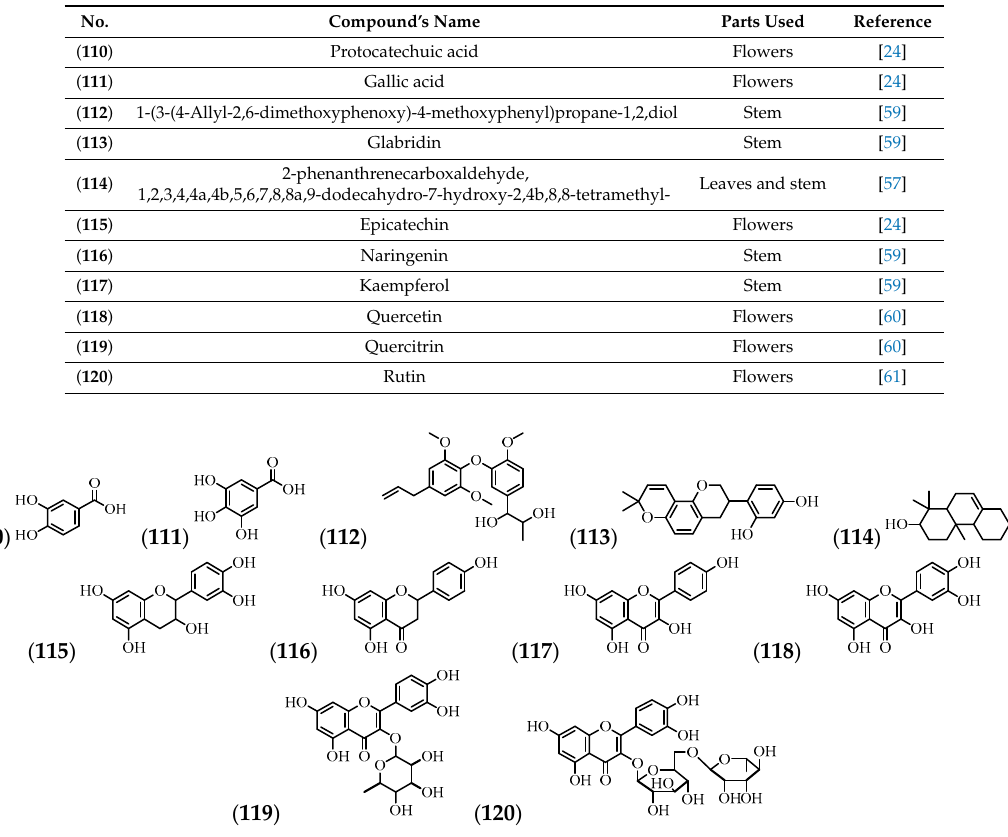
Figure 6. The structures of the phenolic compounds and flavonoids from A. cathartica.